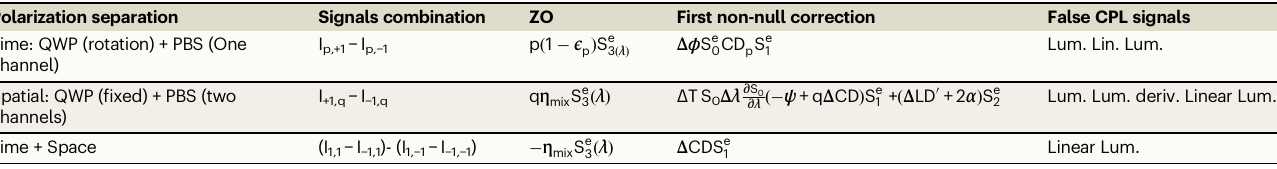
Table 2 | CPL calculated at different orders of the experimental limitations using Equation (1) for three signal combinations Polarization separation Signals combination